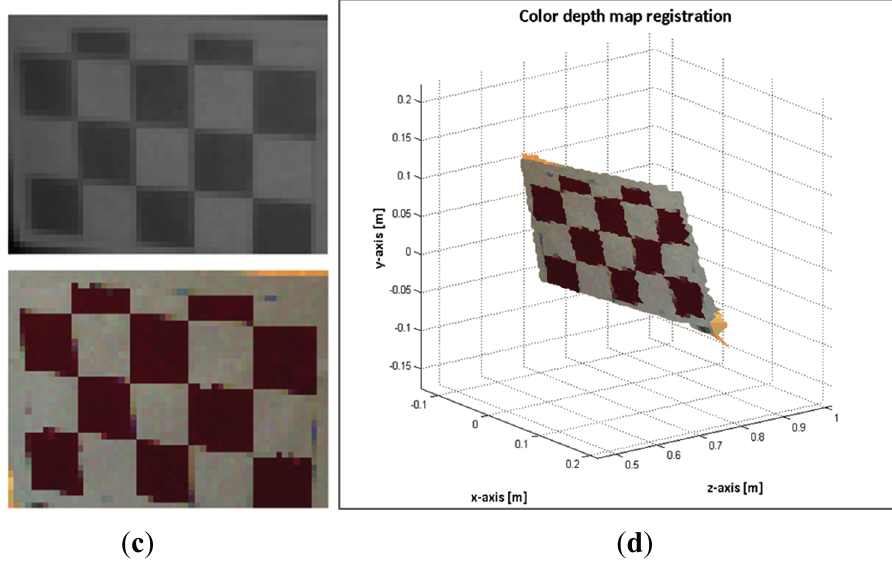
Figure 12. Image sample 25. ( a ) selected points on the ToF; ( b ) estimated points on the RGB image; ( c ) Top: selected ToF ROI. Bottom: estimated RGB ROI; ( d ) colour depth map of the ROI.